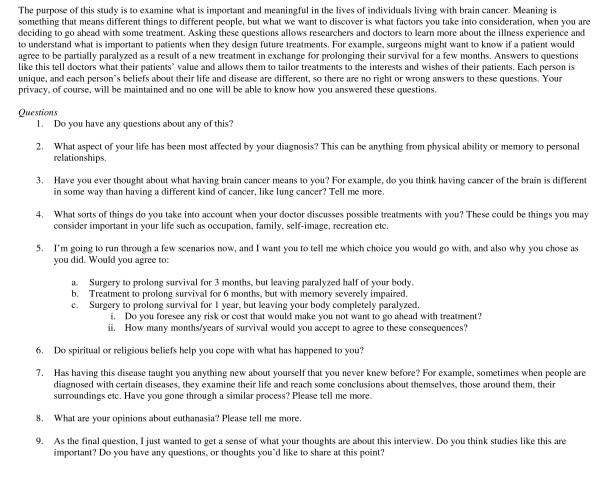
Interview Guide.